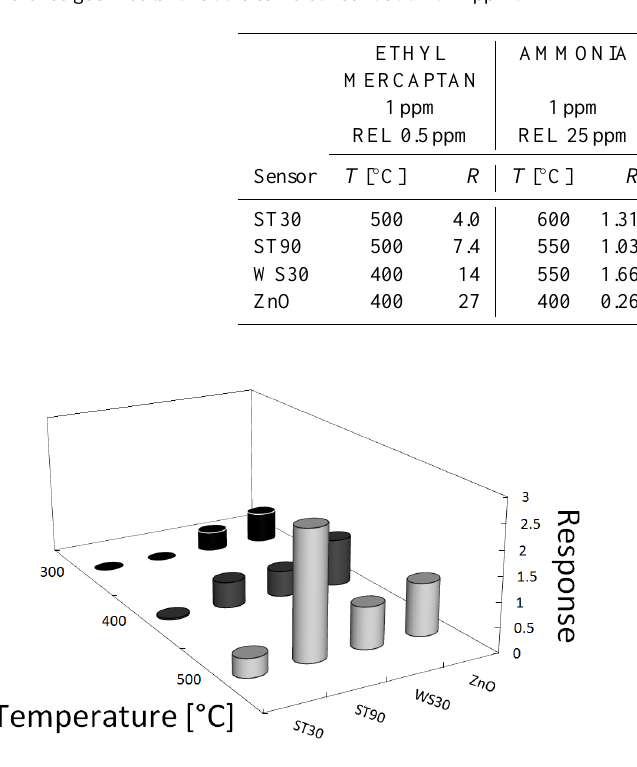
Figure 7. Responses of the sensors to 10ppm of CO at three di ff er- ent temperatures.